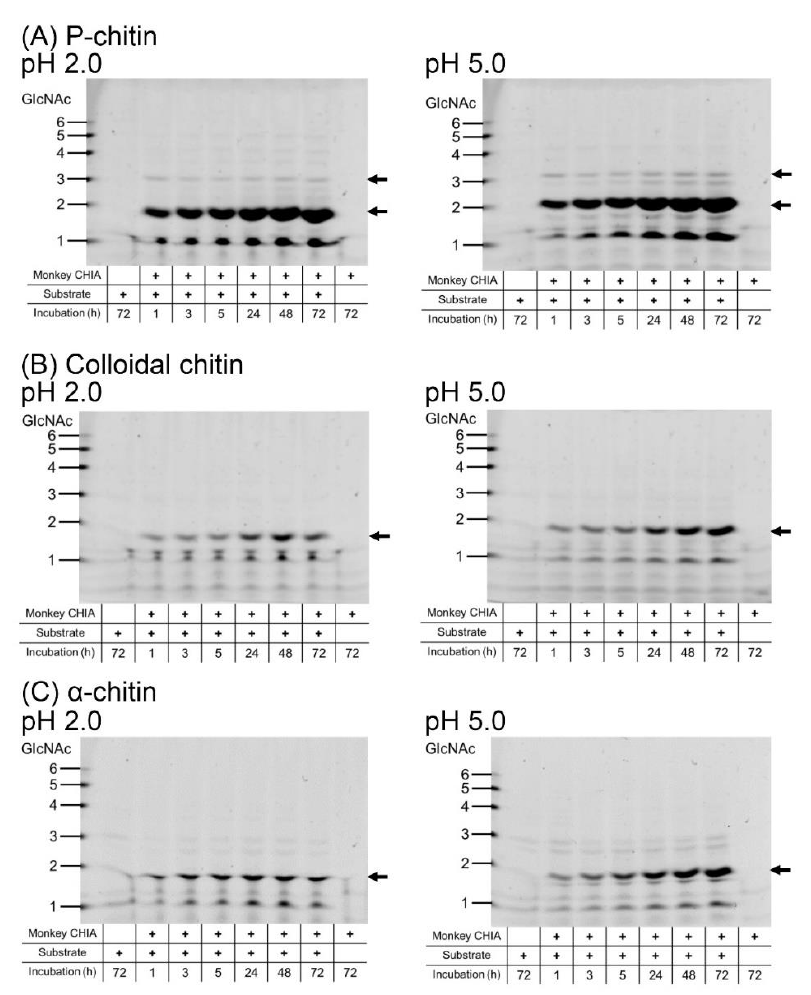
Figure 2. Fluorophore-assisted carbohydrate electrophoresis (FACE) analysis of chitin substrate degradation by monkey CHIA. The substrates, P-chitin ( A ), colloidal chitin ( B ), and α -chitin ( C ), were incubated with monkey CHIA at pH 2.0 or 5.0 and 50 °C for 1, 3, 5, 24, 48, and 72 h. Left panels show results of the reactions at pH 2.0; right panels show results of the reactions at pH 5.0. Full-length gel images are shown in Supplementary Figure S6. The resulting products were analyzed by the FACE method. Size standards on the left margin are defined as chitin oligomers.